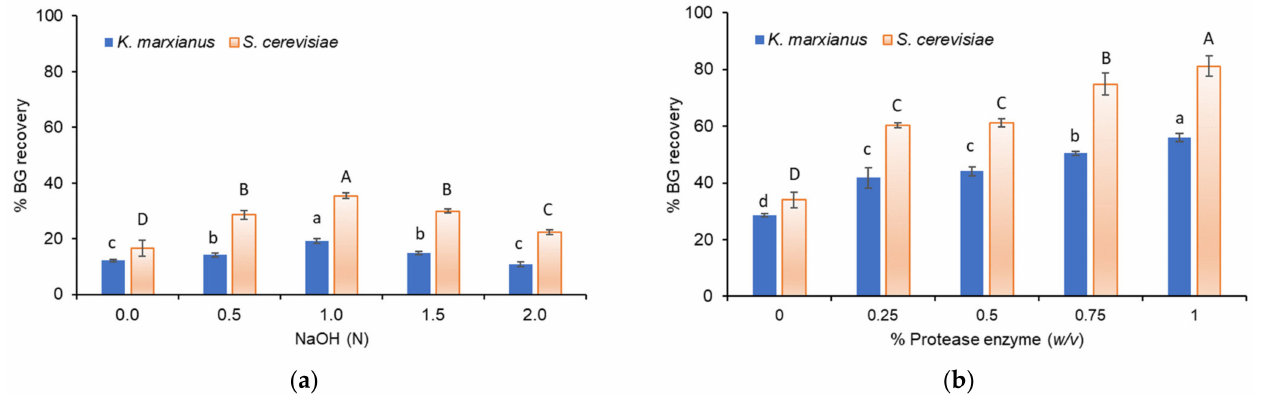
Figure 2. BG recovery by alkaline ( a ) and enzyme ( b ) methods using cells of K. marxianus TISTR 5925 and S. cerevisiae Kyokai NO. 9 as raw materials. Different letters a–d and A–D indicate statistically sig- nificant differences ( p < 0.05) according to Duncan’s multiple range test. Error bars show mean ± SD ( n = 3).